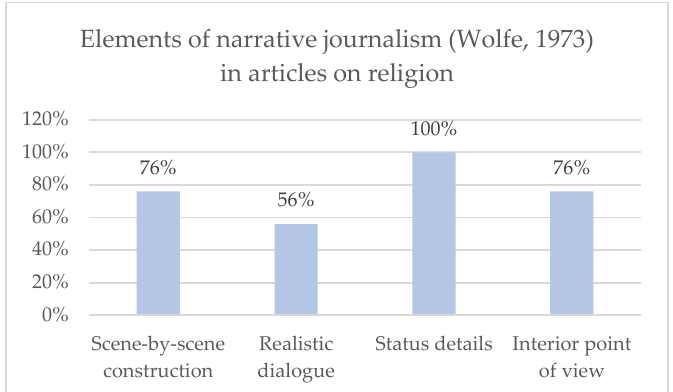
Figure 2. Presence of the elements of narrative journalism according to Tom Wolfe (1973) in the analysed articles on religion.